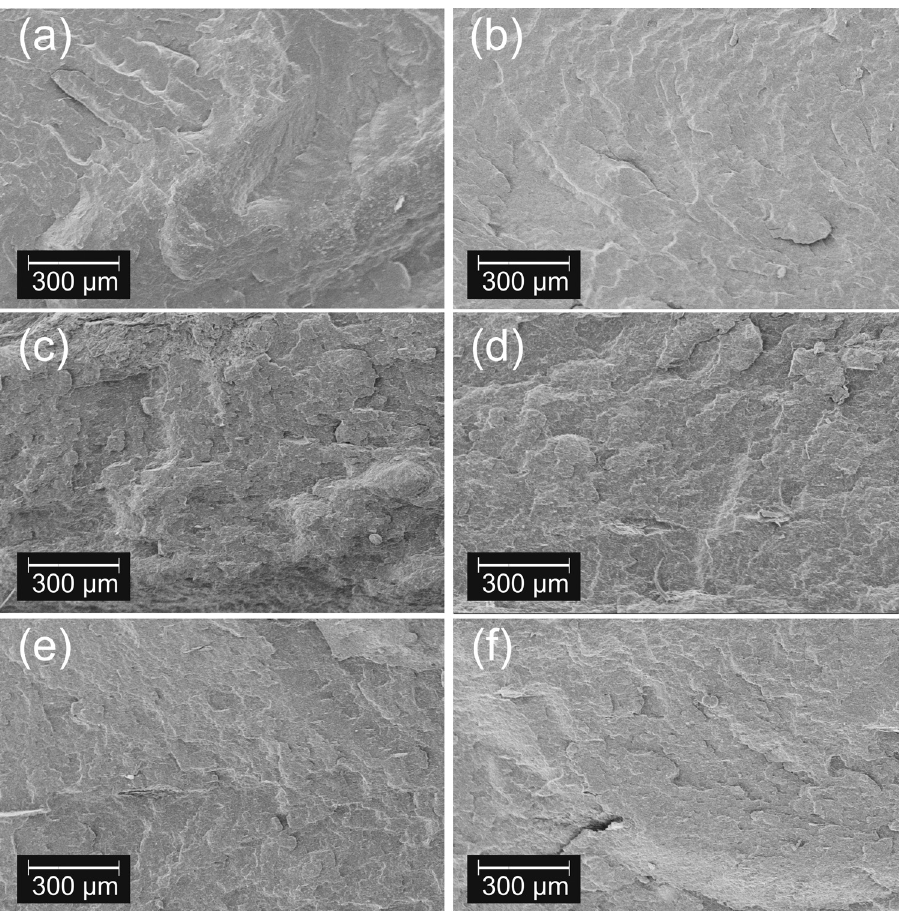
Figure 1: SEM micrographs of BR/CR rubber nanocomposites; ( a ) BR/CR/CB20, ( b ) BR/CR/ATH50/CB20, ( c ) BR/CR/MLG3/CB5, ( d ) BR/CR/ATH50/MLG3/CB5, ( e ) BR/CR/ATH47/MLG3/CB20, ( f )